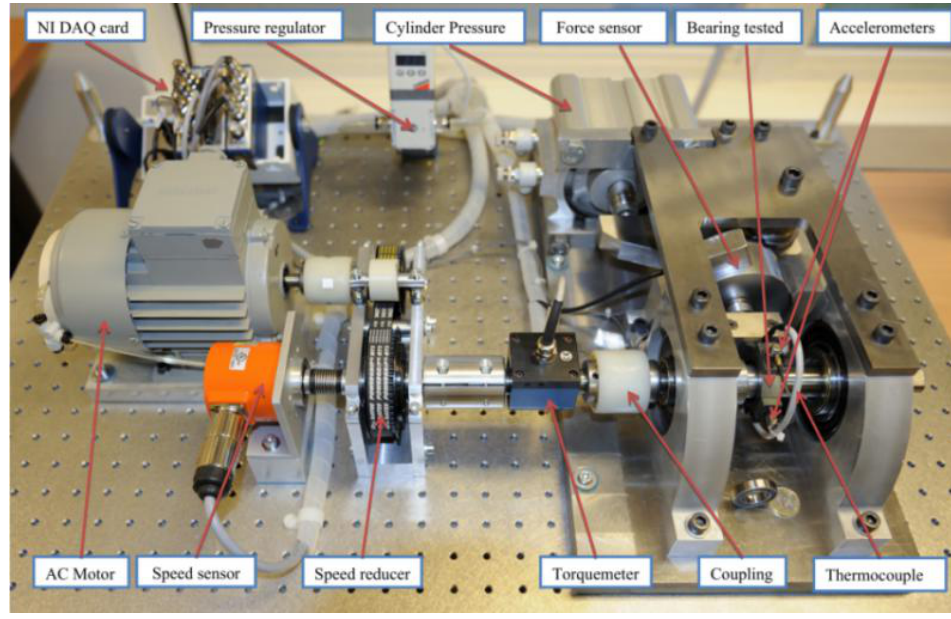
Figure 7. PRONOSTIA test platform